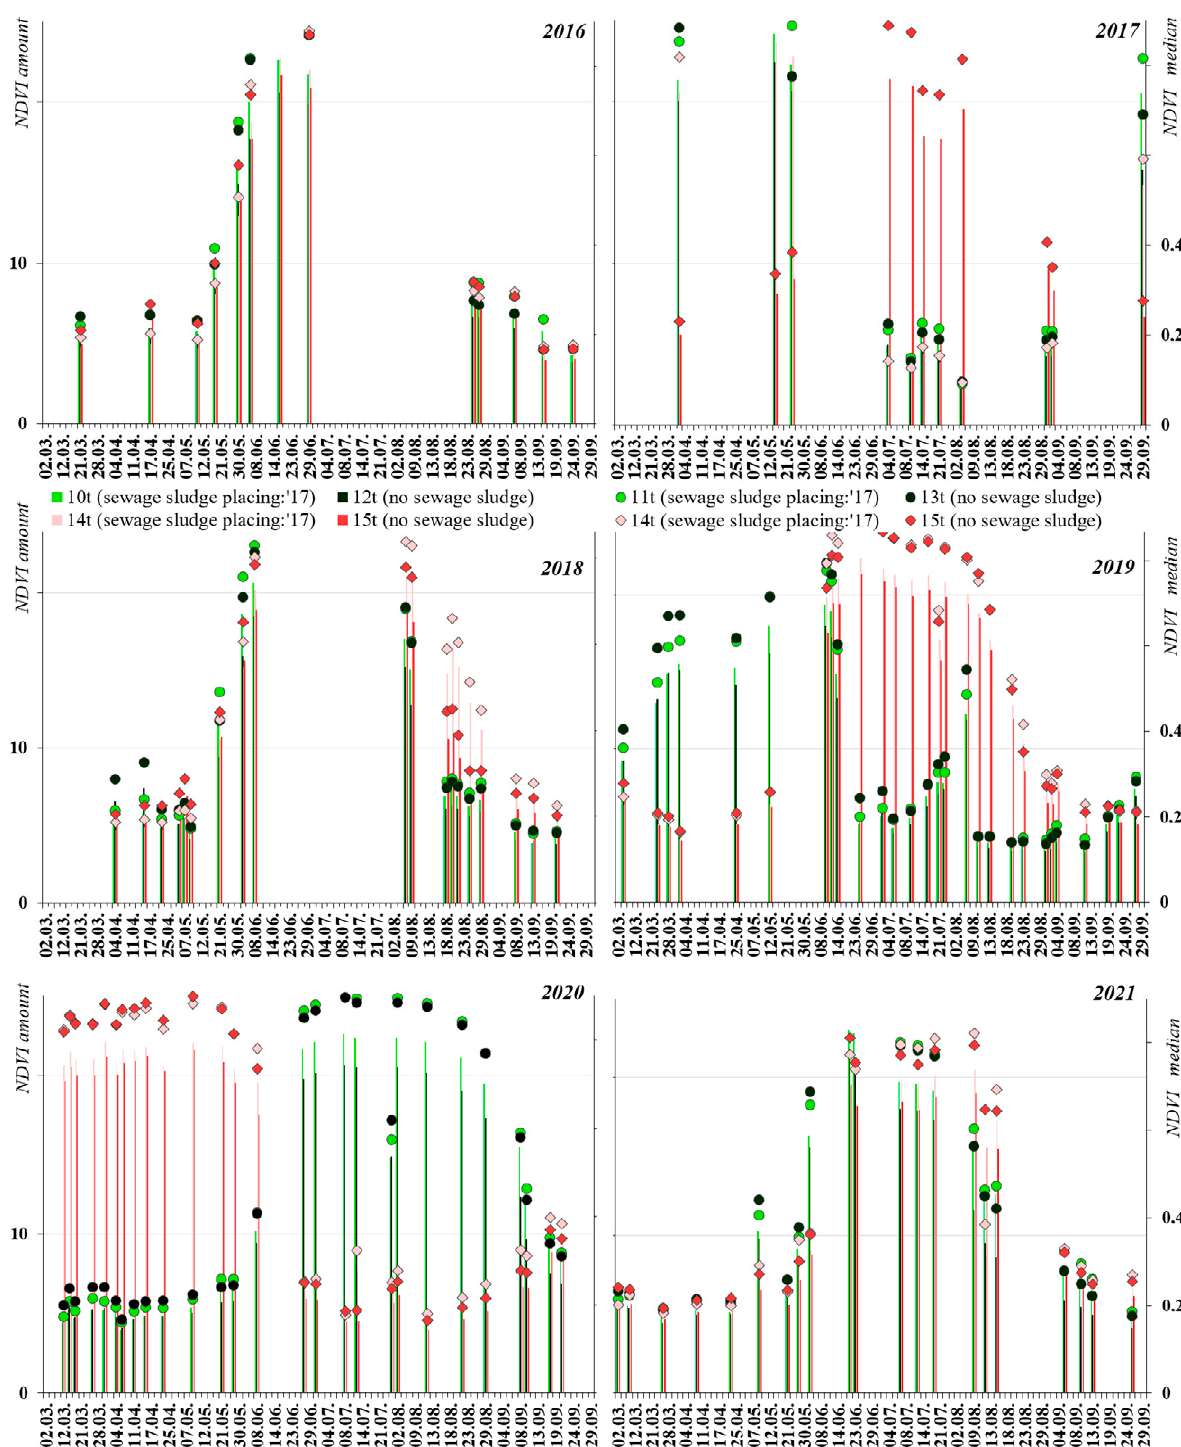
Figure 5. NDVI values of quadrates of Kardos study site between 2016 and 2021 (points: NDVI median, columns: NDVI total) (10t-11t and 14t: sewage sludge placing in 2017; 12t-13t and 15t: no sewage